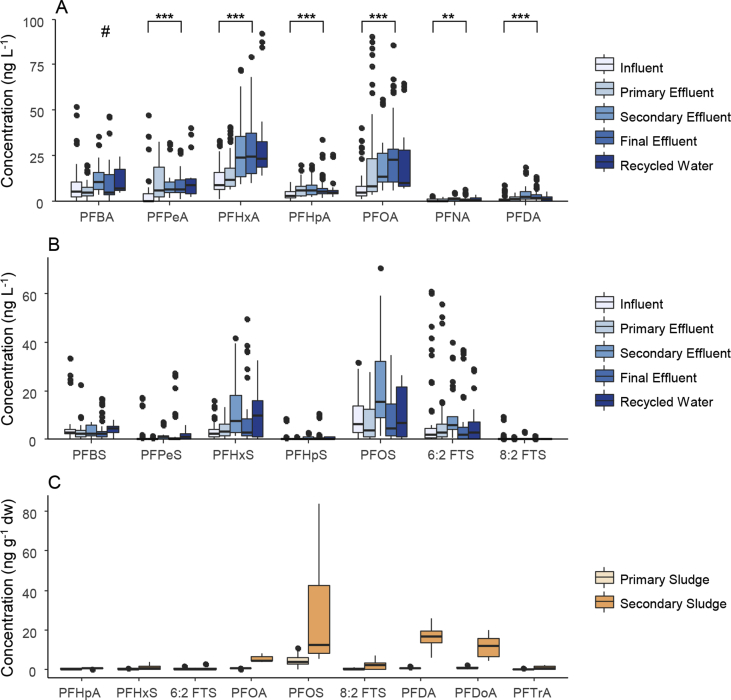
Boxplots of pooled data from 19 WWTPs for A) PFCAs (perfluorocarboxylic acids); B) PFSAs (perfluorosulfonates) and FTSs (fluorotelomer sulfonates) in aqueous samples; C) selected PFAS in solid samples. Aqueous sample locations were influent (n = 57), primary effluent (n = 39), secondary effluent (n = 24), final effluent (n = 57) and recycled water (n = 24). Solid sample locations were primary sludge (n = 15) and secondary sludge (n = 15). # indicates concentration outside y-axis range for PFBA. Asterisk (*) indicates significant difference (<0.01 = **; <0.001 = ***) between influent and final effluent concentrations when tested using linear mixed effects analysis.